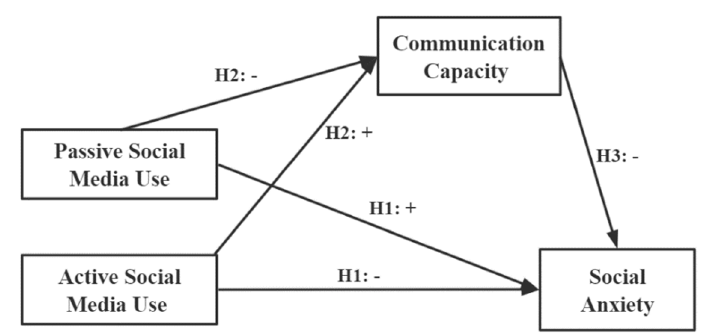
Figure 1. Theoretical mediation model.